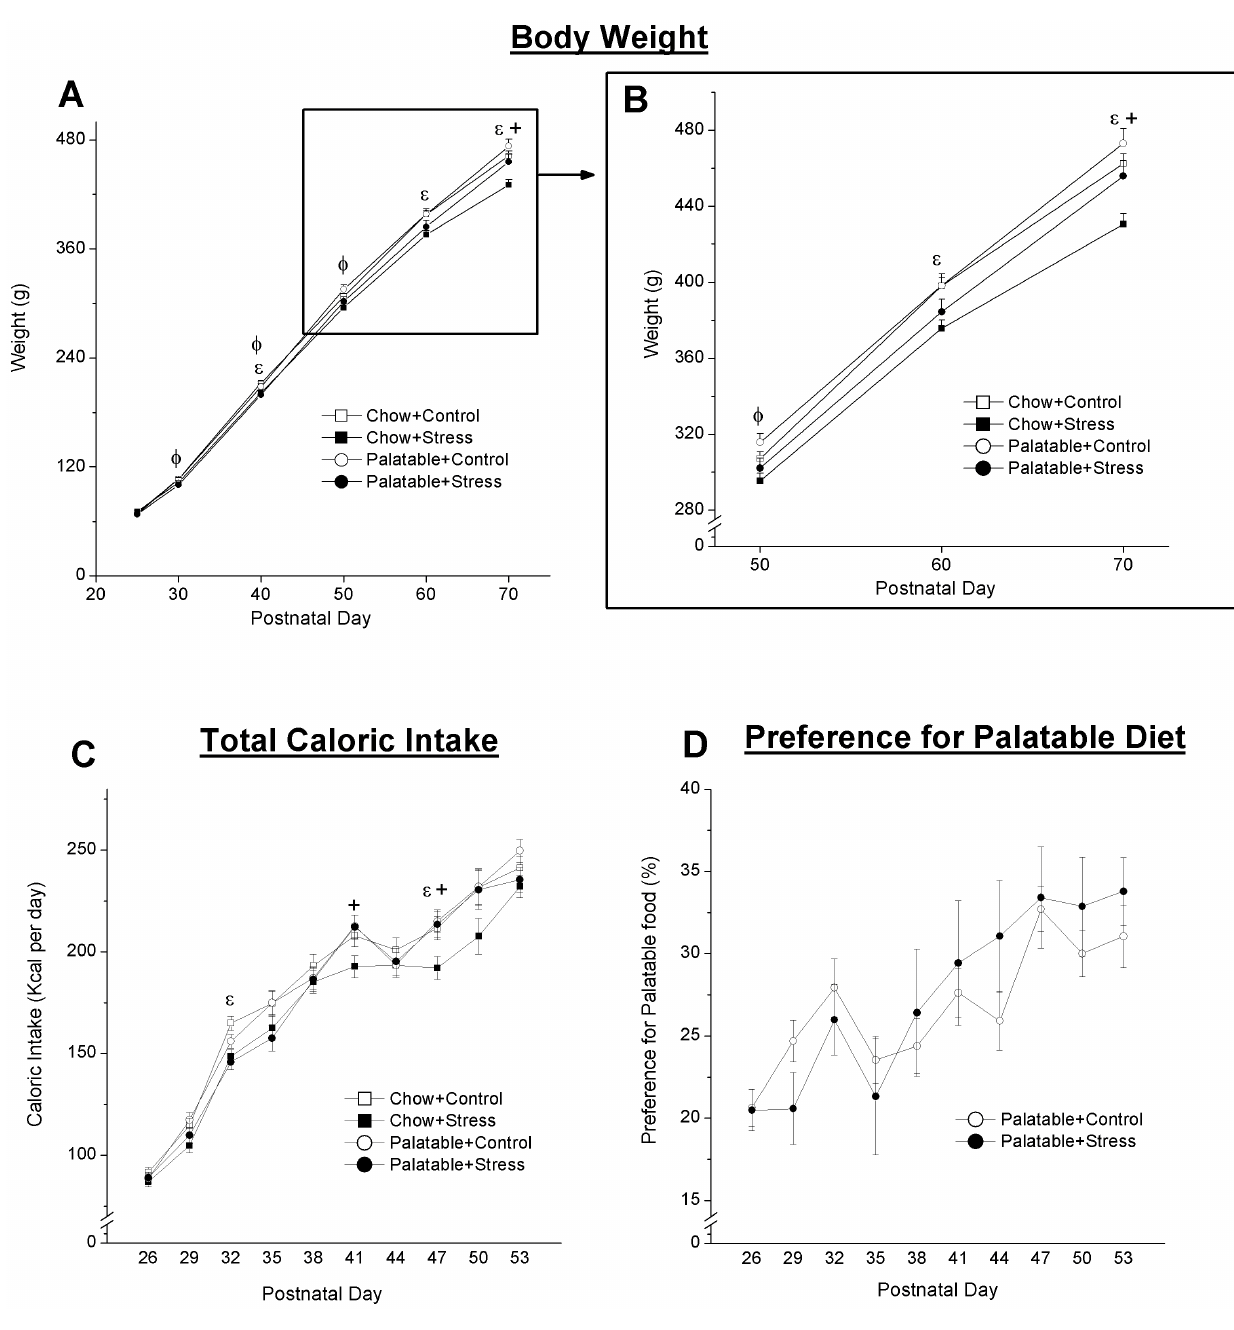
Figure 2. Effect of stress and diet on weight and food intake. Initially, both stress groups gained weight (A and B) at the slower rate relative to their controls; however, this reduction in the rate of weight gain persisted past PD50 in the Chow + Stress group only. A significant difference between stress groups was observed on PD 70. Overall, rats with access to the palatable diet consumed more calories relative to chow-fed rats (C). No significant difference in preference for the palatable diet was observed (D). Lines represent mean 6 SEM. e Significant difference between Chow and Chow + Stress. Q Significant difference between Palatable and Palatable + Stress. + Significant difference between the two stress groups receiving opposite diets. doi:10.1371/journal.pone.0096573.g002 and subcutaneous inguinal (F 1,52 = 10.93 p = .002) fat pads. Two- as well as the chow-fed control group (p = .006). No significant way ANOVA of mesenteric fat pad weight revealed a significant differences in inter-scapular brown fat were observed (F 1,52 = 1.69 p . .1) Diet 6 Stress interaction (F 1,52 = 4.75 p = .034). Follow-up simple effects analysis revealed that previously stressed rats with access to chow displayed significant decreases in mesenteric fat relative to previously stressed rats with access to the palatable diet (p , .001),